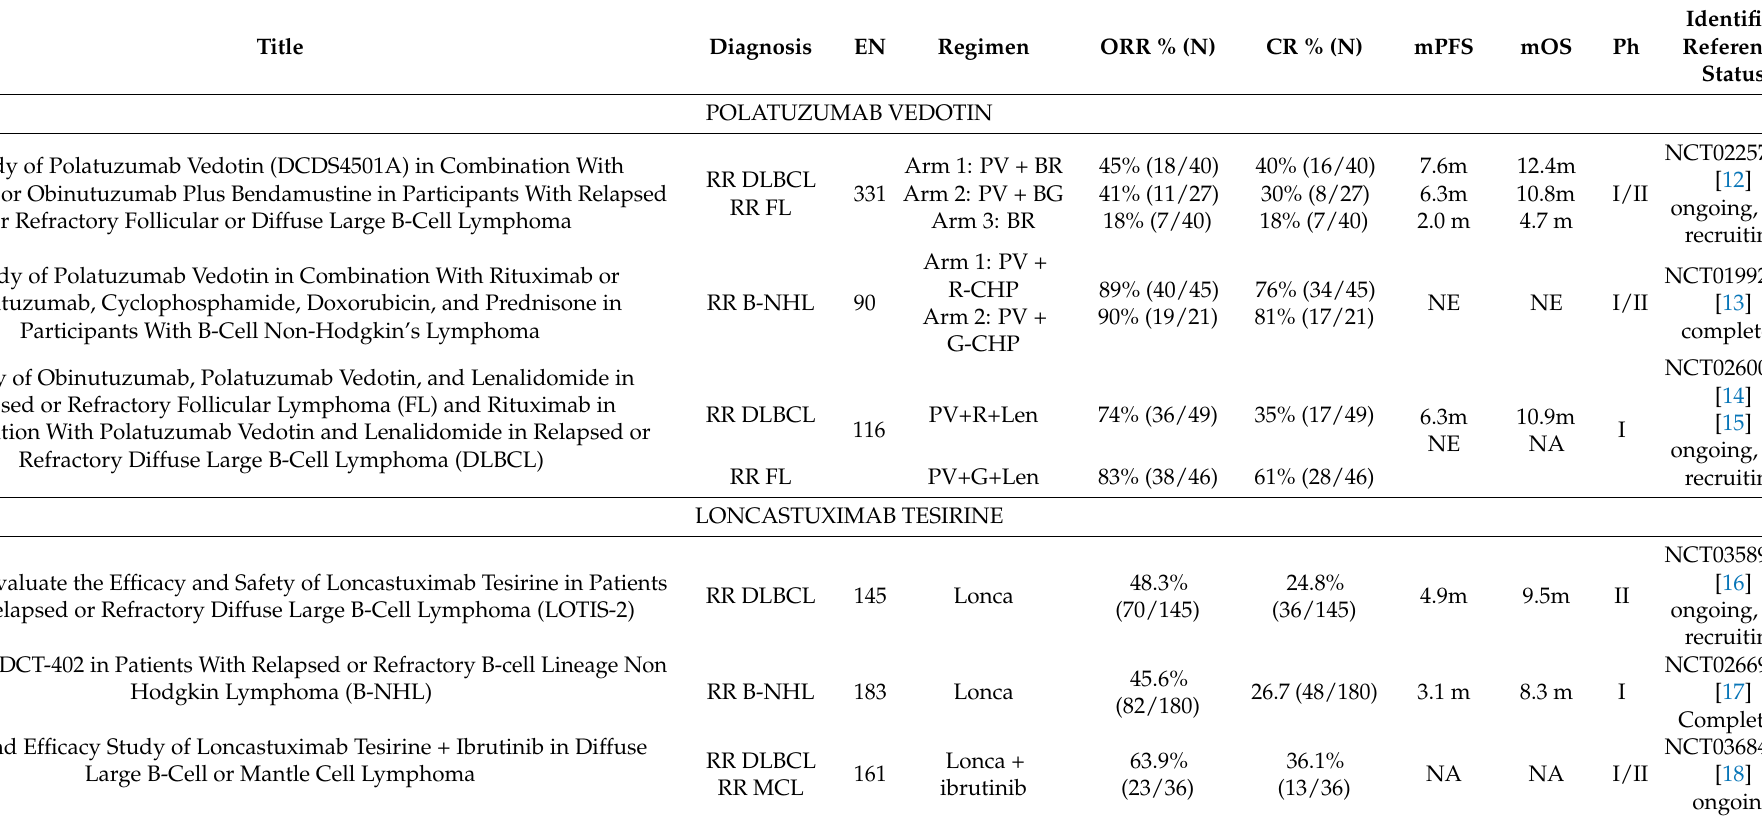
Table 2. Antibody-drug conjugates-available results of phase I-III clinical trials; EN, estimated enrollment; ORR, overall response rate; CR, complete remission; PR, partial remission; NA, not available; mPF, median progression free survival; mOS, median overall survival; m, month; RR, relapse and/or refractory; Ph, phase; B-NHL, B-cell non-Hodgkin lymphoma; I, indolent; a, aggressive; N, number; DLBCL, Diffuse large B-cell lymphoma; FL, follicular lymphoma; GZL, gray zone lymphoma; PV, polatuzumab vedotin; BV, brentuximab vedotin; Lonca, Loncastuximab tesirine; CHOP, cyclophosphamide, doxorubicin, vincristine, prednisone; CHP, cyclophosphamide, doxorubicin, prednisone; R, rituximab; G, Obinutuzumab; BR, bendamustine, rituximab; BG, bendamustin, obinutuzumab; NR, not reached; NE, not evaluable; m,